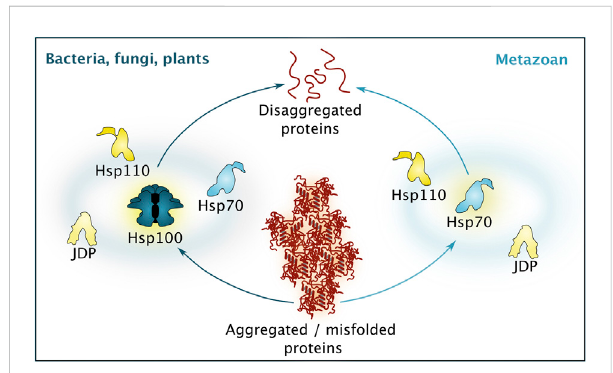
FIGURE 3 Simpli fi ed comparison between different disaggregation machineries. While bacteria, fungi and plants rely of disaggregation based on the activity of a Hsp100 isoform, supported by Hsp70, Hsp110 and a diverse set of J-domain proteins (JDP), metazoan disaggregation is based on Hsp70 activity, supported by co- chaperones belonging to the Hsp110 and JDP class. Please note that additional chaperones and protein quality control factors are involved to guarantee ef fi cient